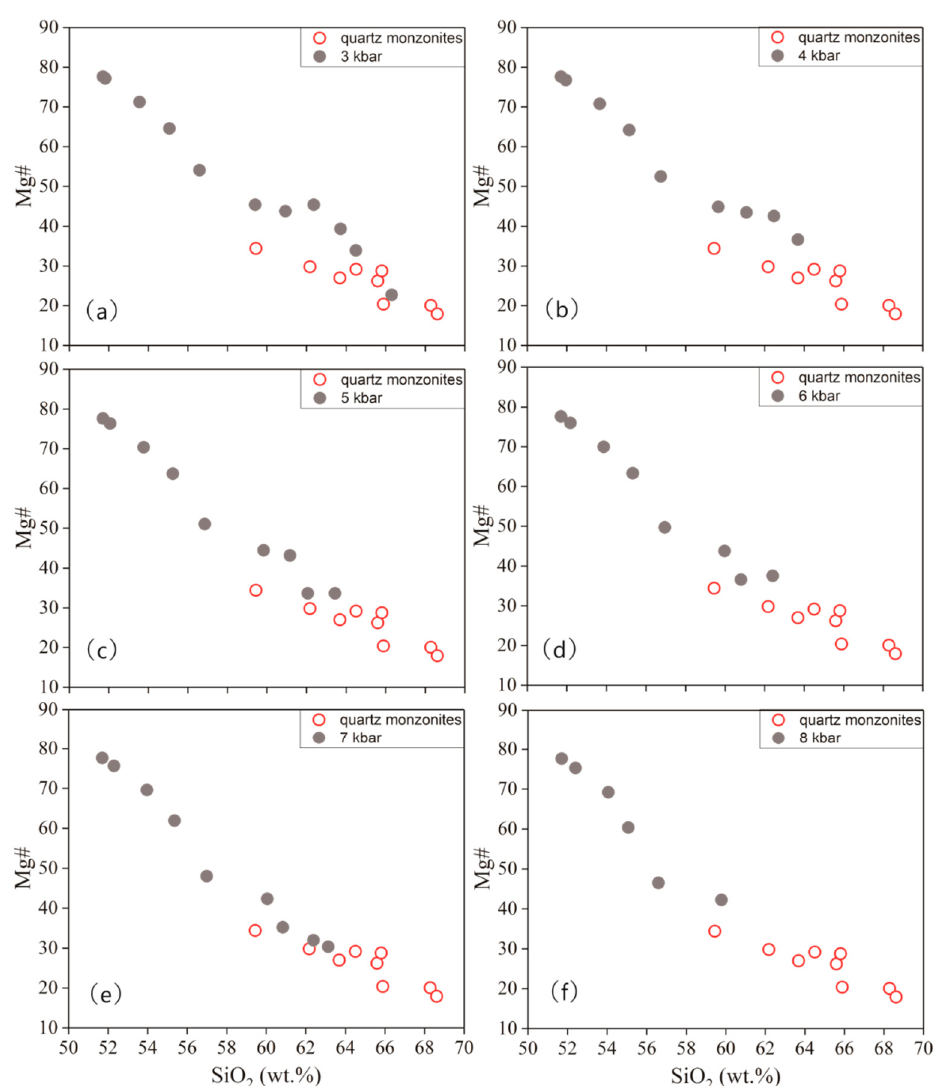
Figure 17. SiO 2 vs. Mg# diagram for Muchen quartz monzonites and simulative magma. ( a – f ) represent the simulate results in different temperature (T) and pressure (P) condition. ( a ): T = 3 kbar, and T = 1500 °C, 1400 °C, 1300 °C, 1200 °C, 1100 °C, 1000 °C, 950 °C, 900 °C, 850 °C, 800 °C, 750 °C ；